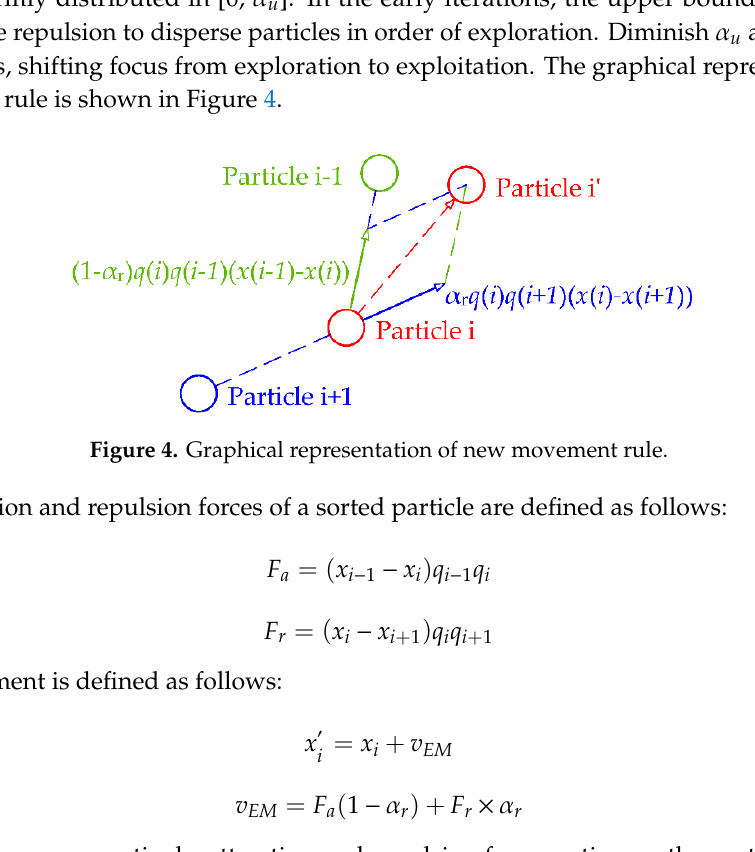
7 of 20 Figure 3. Graphical representation of the new local search method. 